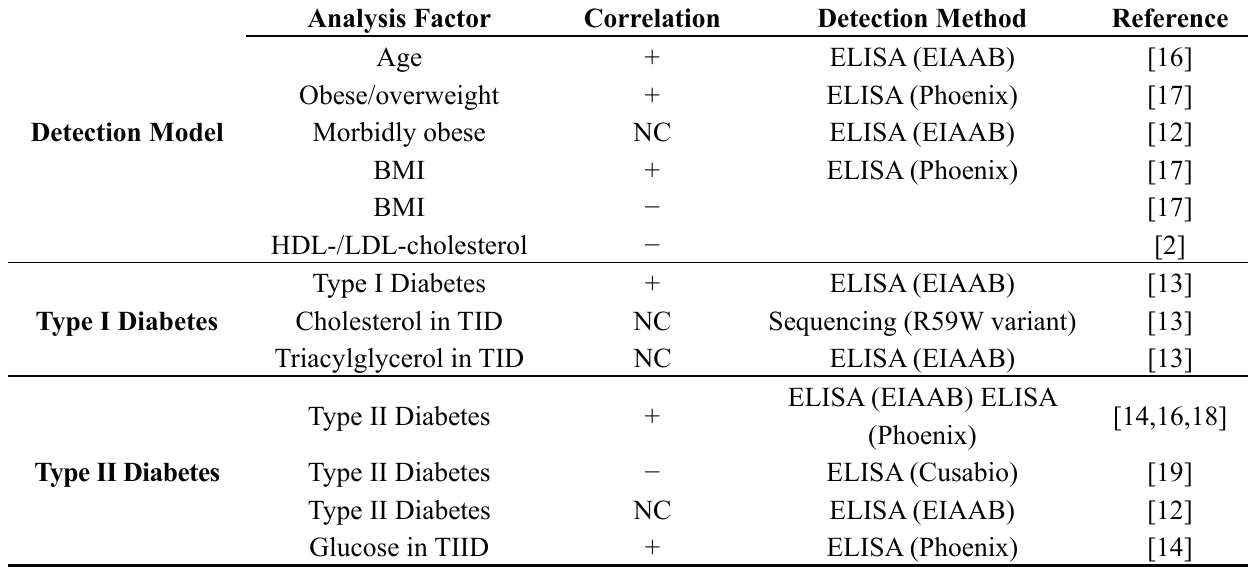
Table 1. Clinical correlation of betatrophin in